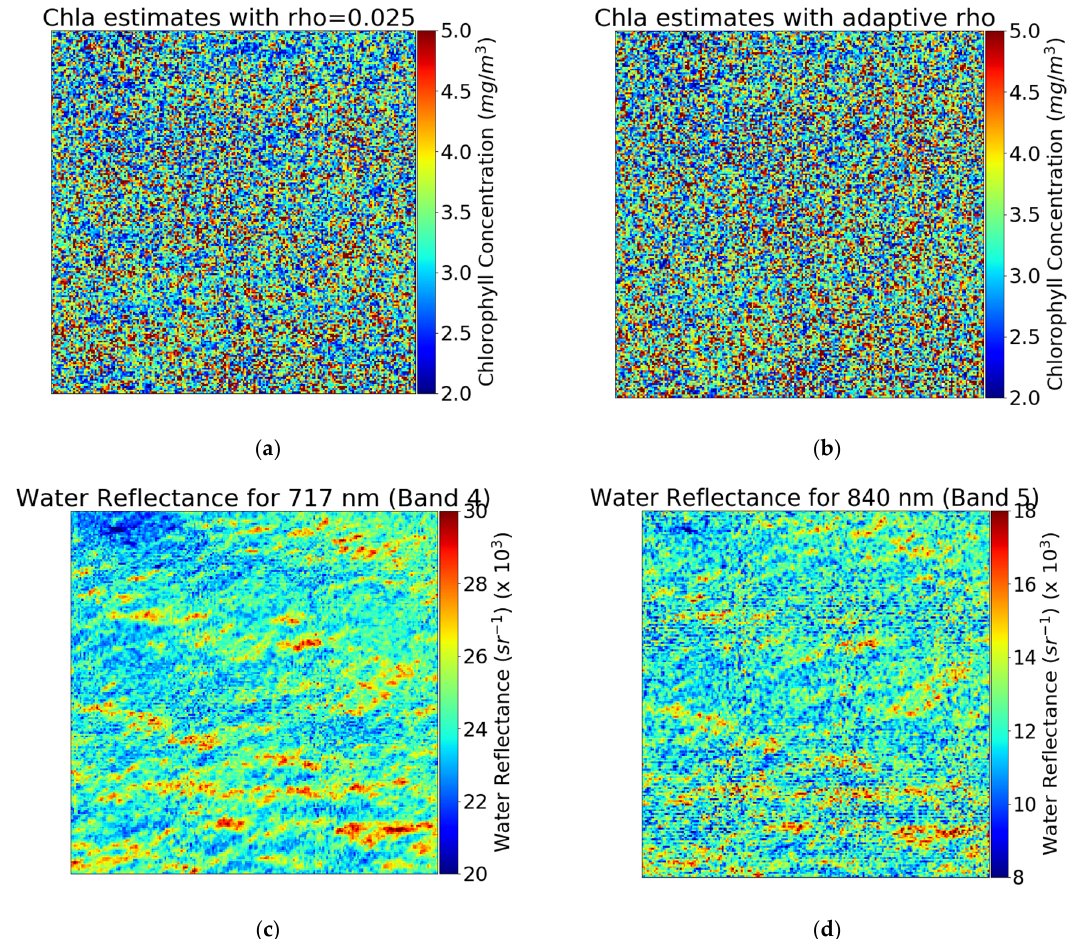
Figure 6. Chla images for the subset area marked in Figure 5, with ( a ) the fixed ρ and ( b ) the adaptive ρ , and water reflectance images for Band 4 ( c ) and Band 5 ( d ). A regression analysis was performed on a further subset area (40 × 40 pixels) of the scene.